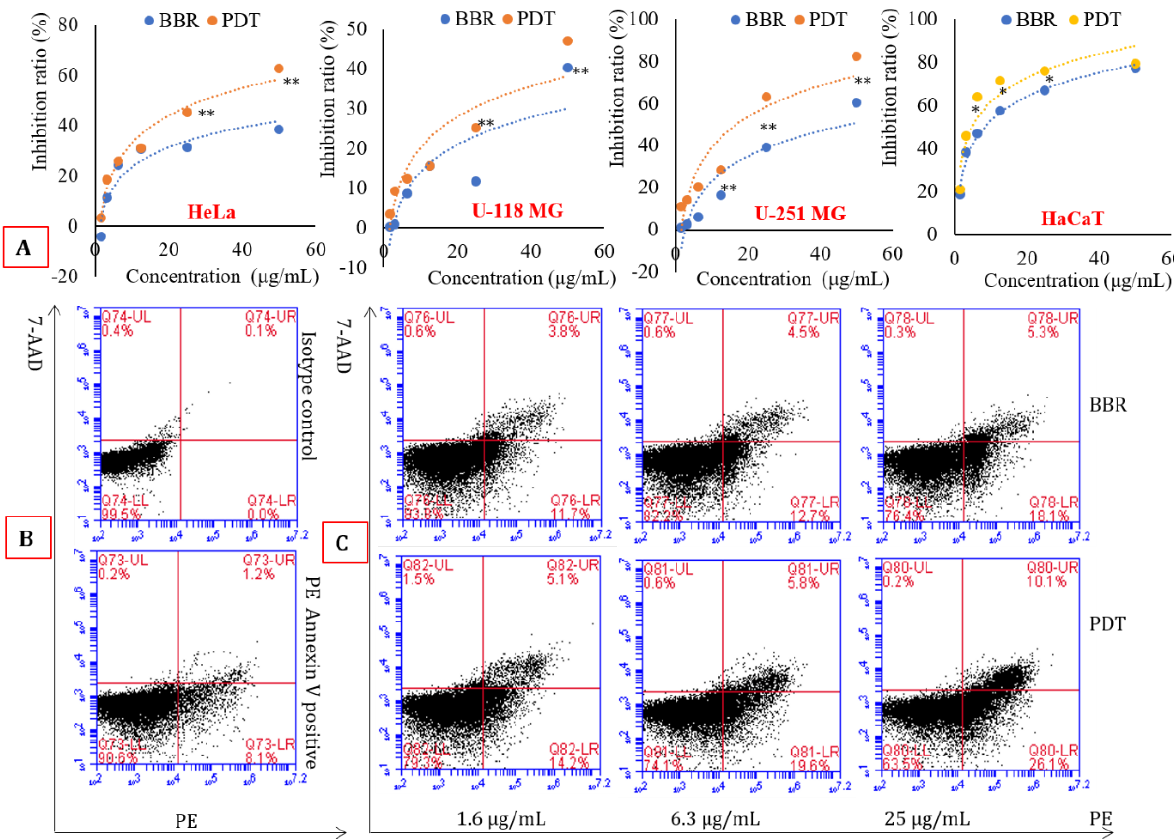
Figure 2: Effects of BBR-mediated PDT on proliferation and apoptosis of cells. ( A). Cell proliferation inhibition, the concentrations of BBR were 0, 1.6, 3.1, 6.3, 12.5, 25 and 50 μg/mL, and the CCK-8 assay showed that absorbance was detected at 450 nm using a reference wavelength of 405 nm. (B). The PE Annexin V positive cell populations were considered apoptotic cells. (C). Concentrations of BBR in the apoptosis test were 1.6, 6.3 and 25 μg/mL. ** P < 0.01, vs BBR